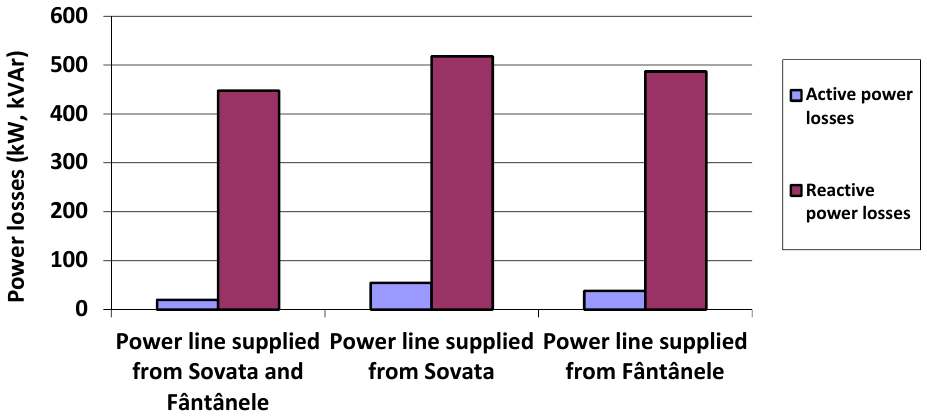
Figure 3. Power losses (EVs not connected).